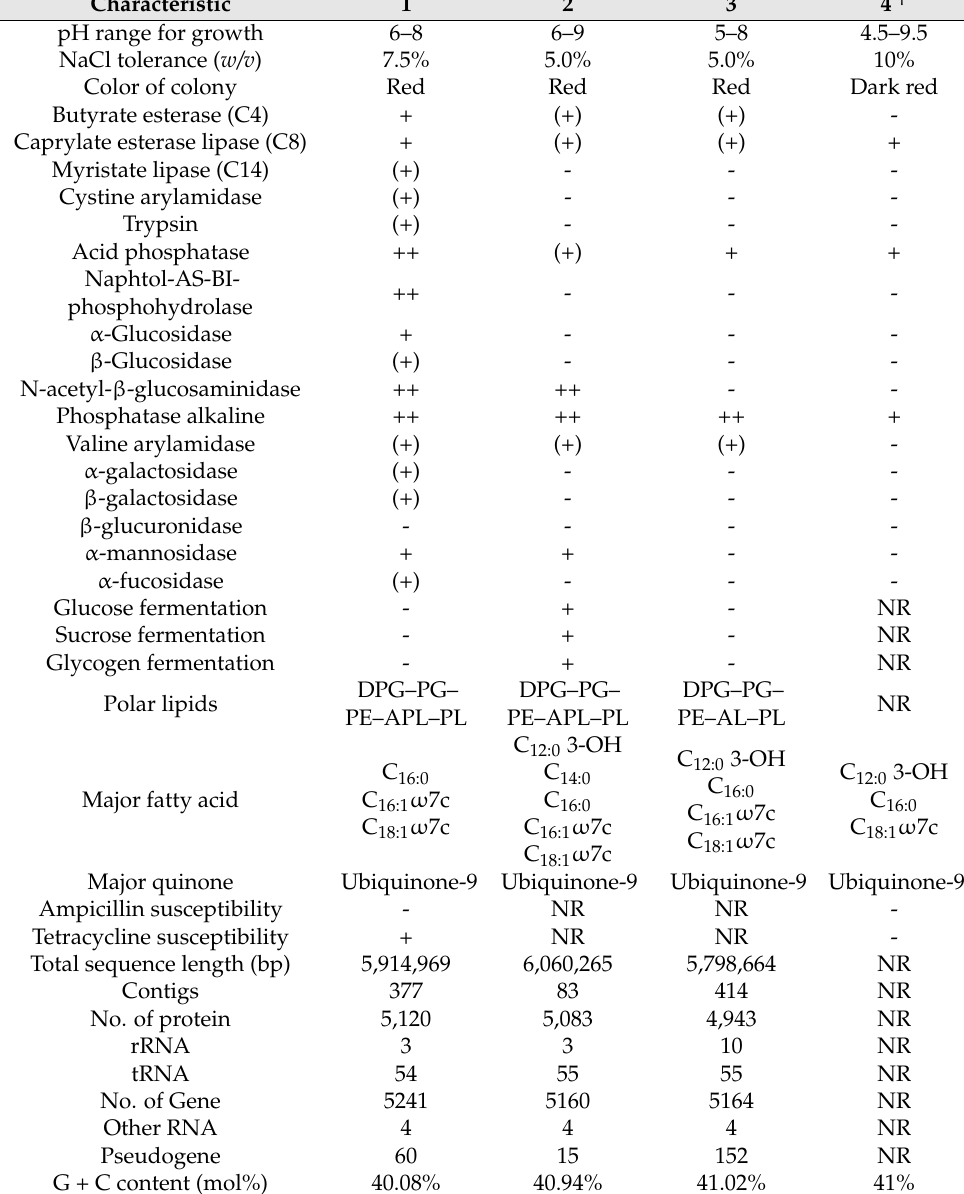
Table 3. Comparison of phenotypic characteristics that distinguish strain WH53 T from the most closely related Zooshikella species. Strains: 1, WH53 T ; 2, Zooshikella marina LMG 28823 T ; 3, Zooshikella ganghwensis DSM 15267 T ; 4, Zooshikella rubidus S1-1 T